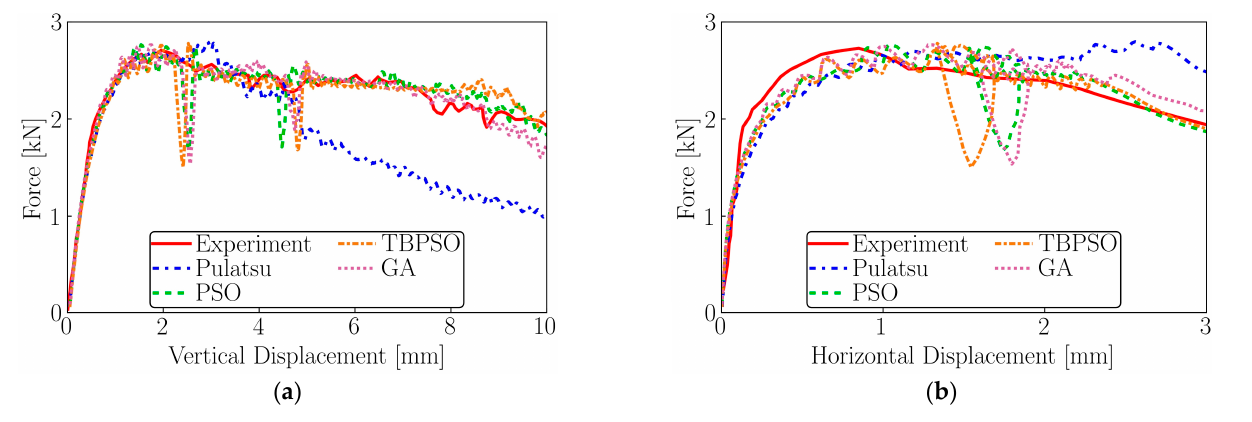
Figure 15. Best calibrated material parameter load displacement diagrams of Pulatsu’s geometry (objective function 1, PSO and GA: 50 iterations; TBPSO: 20 iterations); ( a ) vertical displacement, ( b ) horizontal displacement.